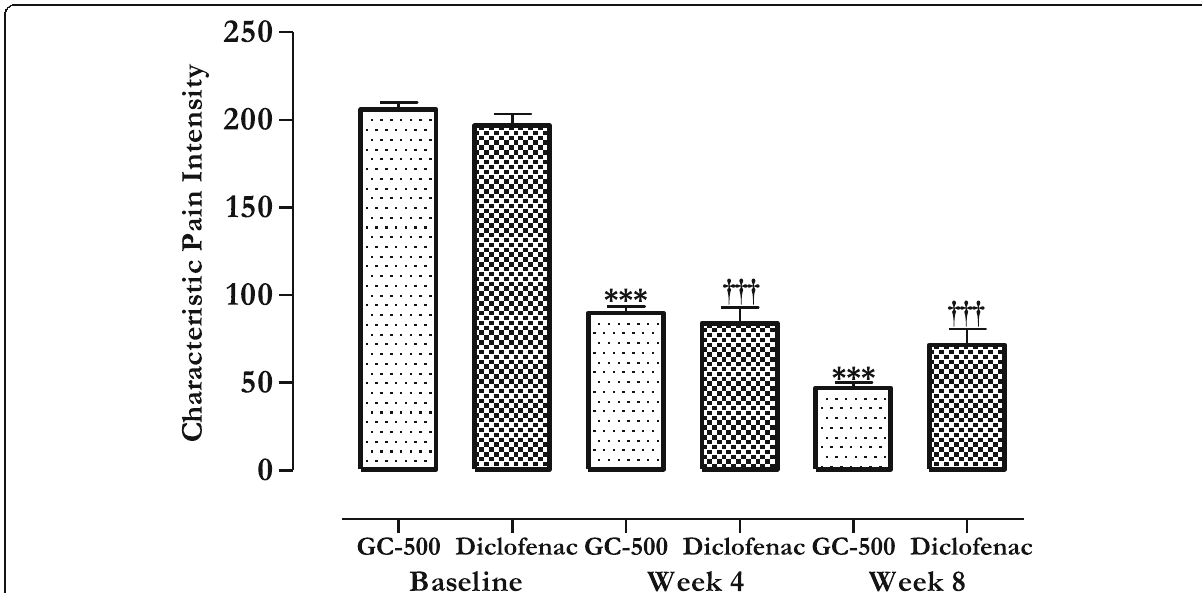
Fig. 6 The effect of GC-500 on Characteristic Pain Intensity of participants compared to Diclofenac. Data is expressed as Mean ± SD. A non- significant difference was observed between the groups p > 0.05 after ANOVA and Bonferroni post-hoc test . *** p < 0.001: GC-500 at week 4 & 8 compared to its baseline . ††† p < 0.001: Diclofenac at Week 4 & 8 compared to its baseline